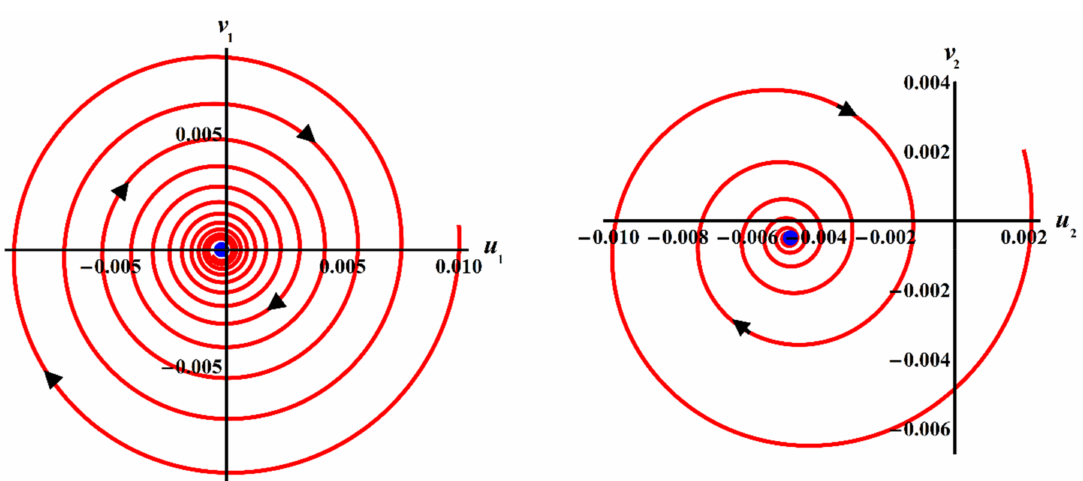
Figure 28. The time histories of u 2 and v 2 .